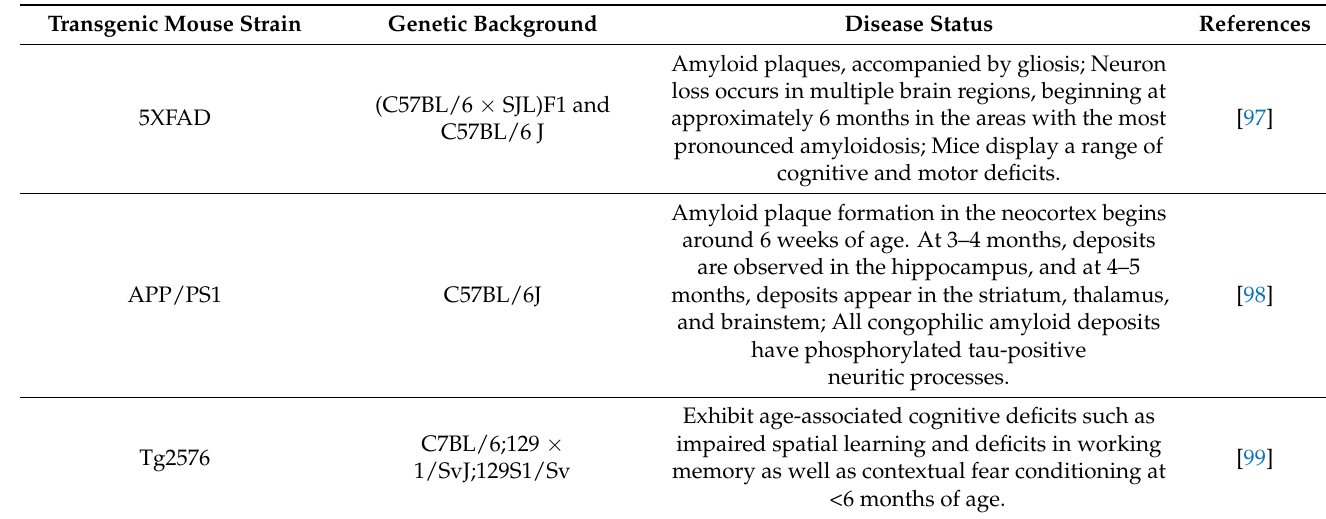
Table 1. Genotypic and phenotypic characteristics of transgenic mouse strains commonly used in AD